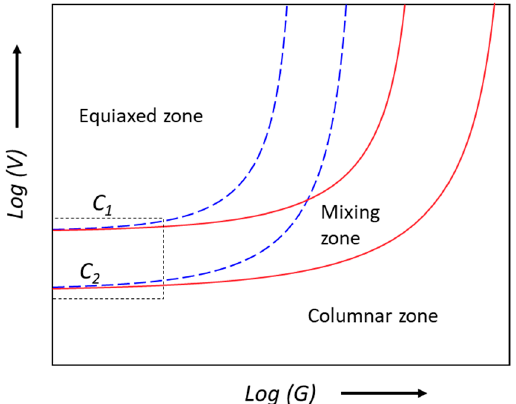
Figure 3. Schematic diagram illustrating the Hunt CET map for two alloys with compositions of C 1 and C 2 ( C 1 < C 2 ), showing three zones: columnar zone, equiaxed zone and mixing zone (between the blue and red lines). The dashed box shows the area with very low temperature gradient ( G ).